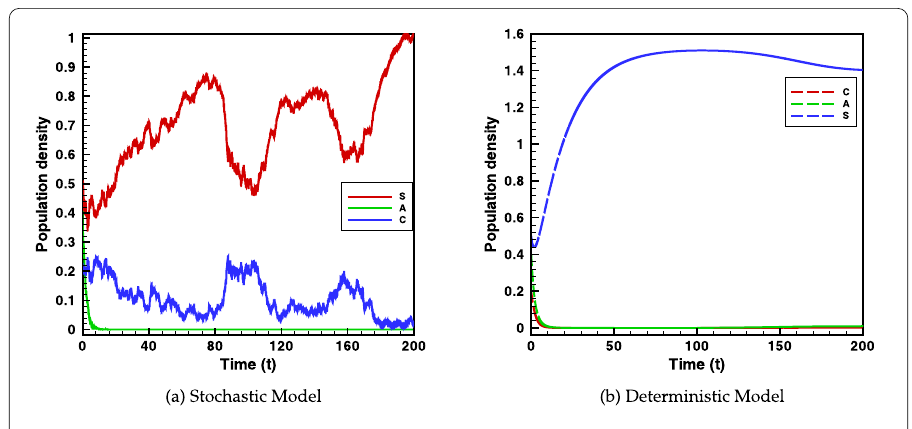
Figure 1 Simulation of system (3) with time step and initial size of the population (cid:11) t = 0.01 and ( S (0), I